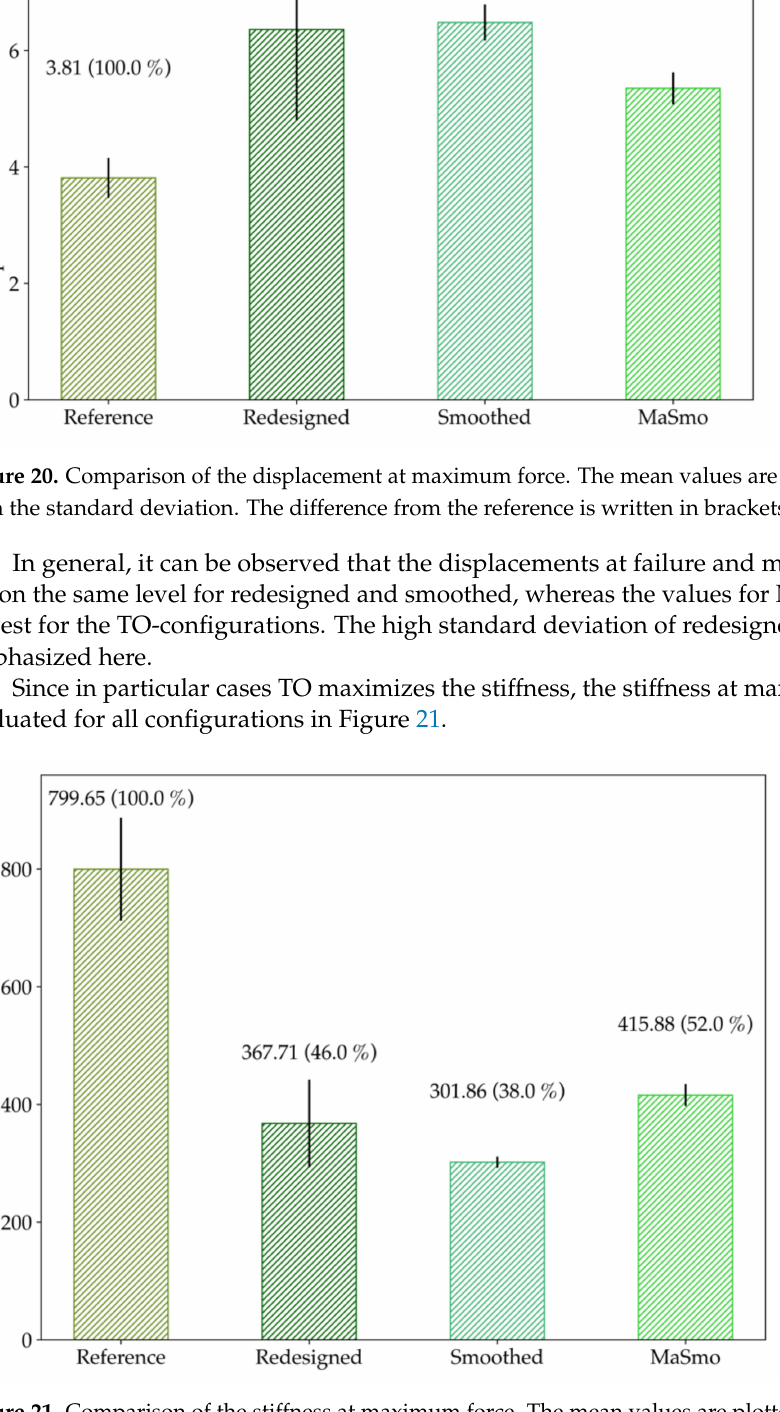
Figure 21. Comparison of the stiffness at maximum force. The mean values are plotted together with the standard deviation. The difference from the reference is written in brackets in